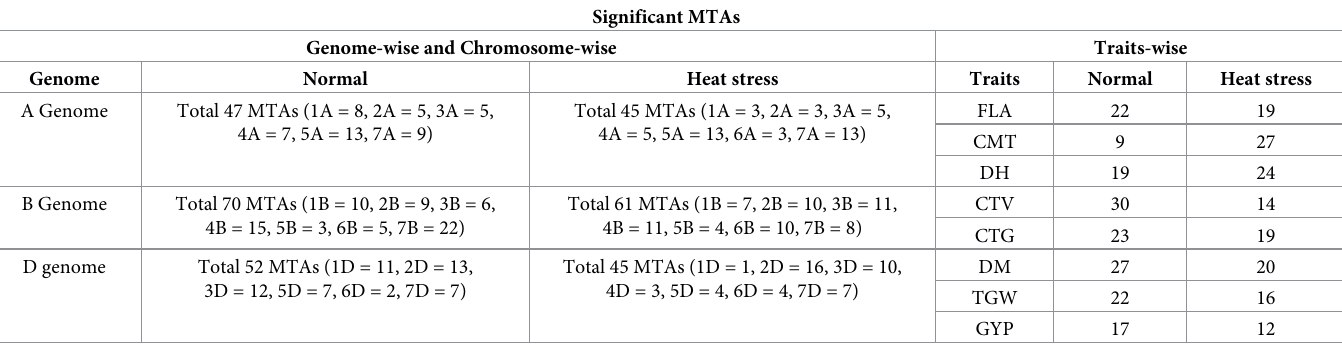
Table 3. Significant MTAs under normal and heat stressed